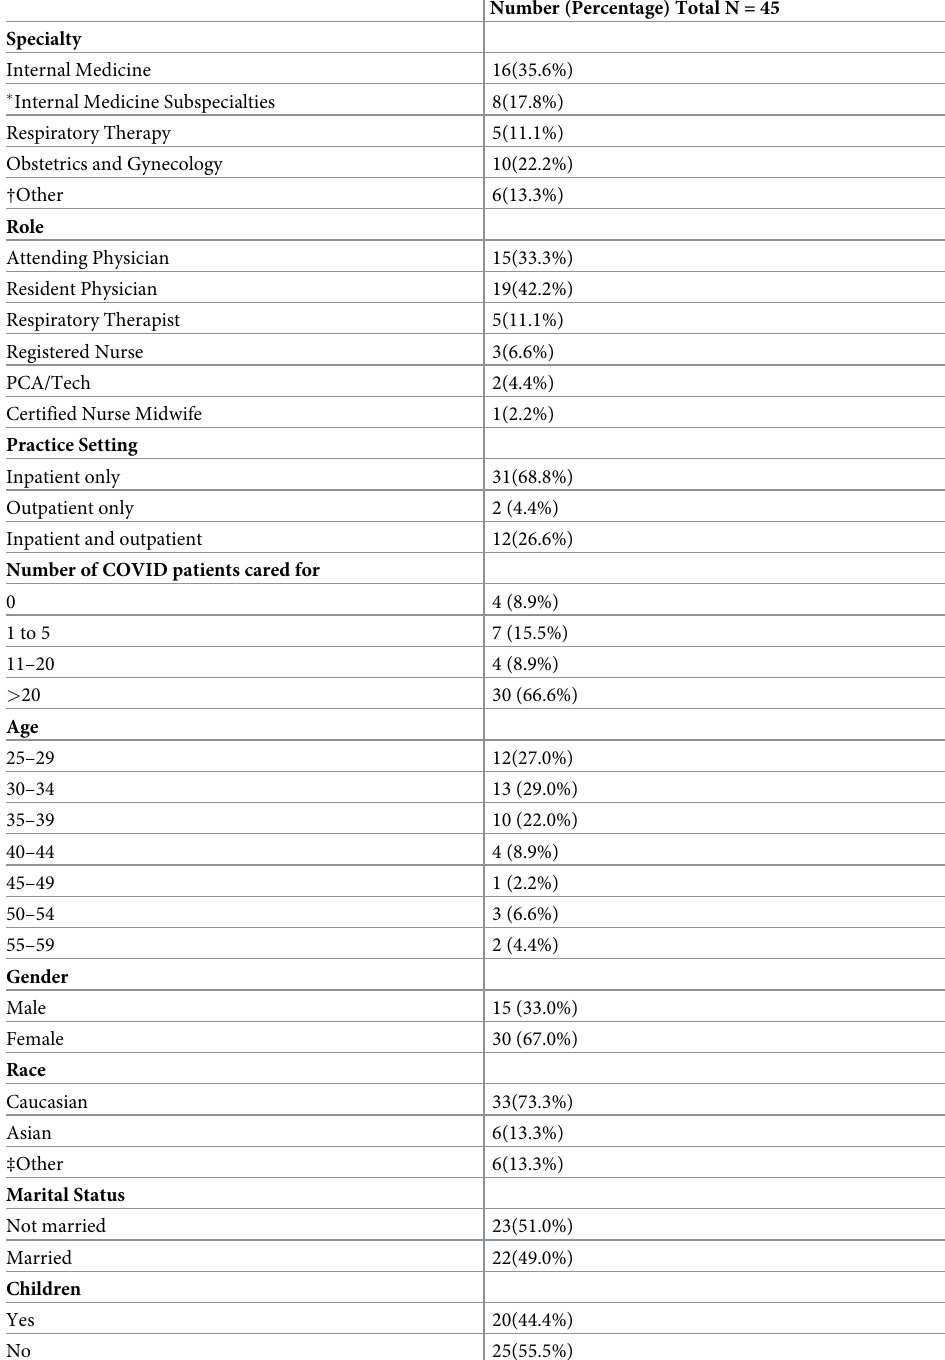
Table 1. Characteristics of study